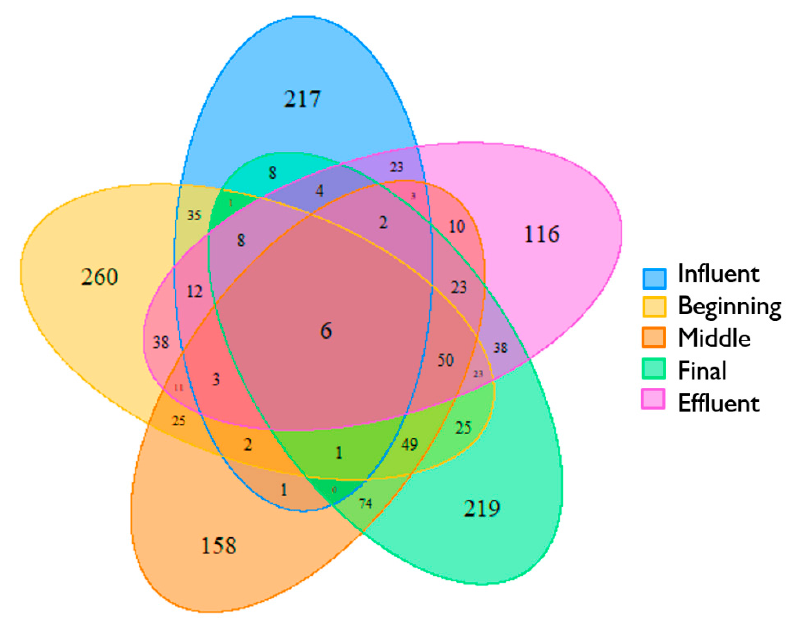
Figure 6. Venn diagram representing the shared OTUs between the different sampling sites of biodigester. Each sample is differentiated by the colors: influent (blue), beginning (yellow), middle (orange), final (green) and effluent (purple). The numbers show the OTUs recovered from that point.